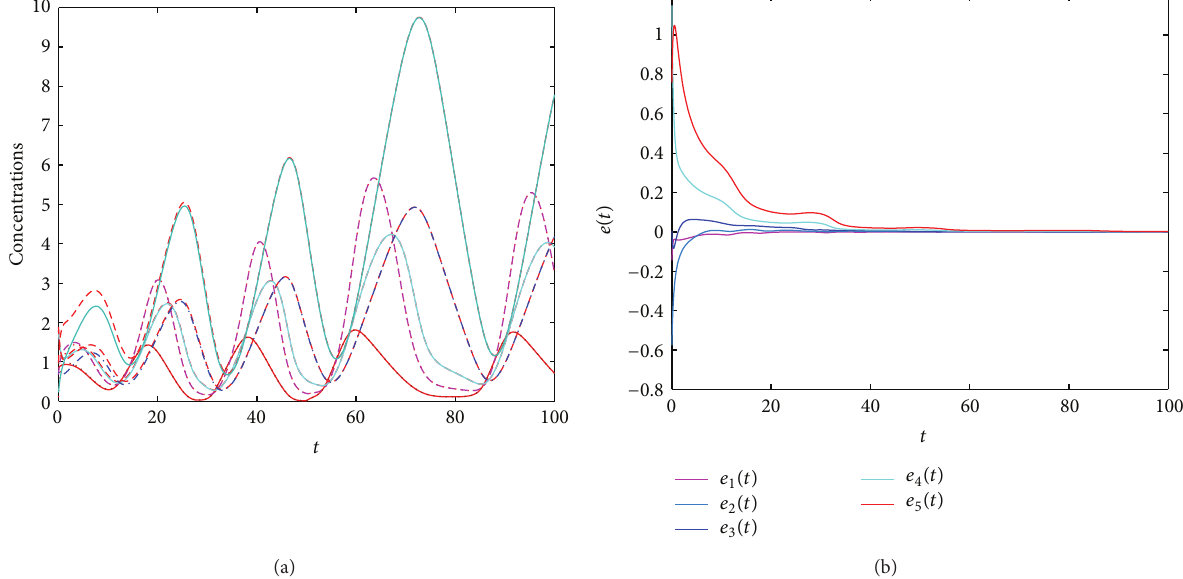
Figure 4: (a) State trajectories of systems (3) and (8) with step input signal 𝑢(𝑡) . (b) The error dynamics of system (11). Here, 𝑦(𝑡) = 𝑐𝑥 1 (𝑡), 𝑘 = 2.5, 𝑐 = 2, and 𝑢(𝑡) = 0 for 𝑡 ≤ 50 and 𝑢(𝑡) = 0.1 for 𝑡 > 50 .